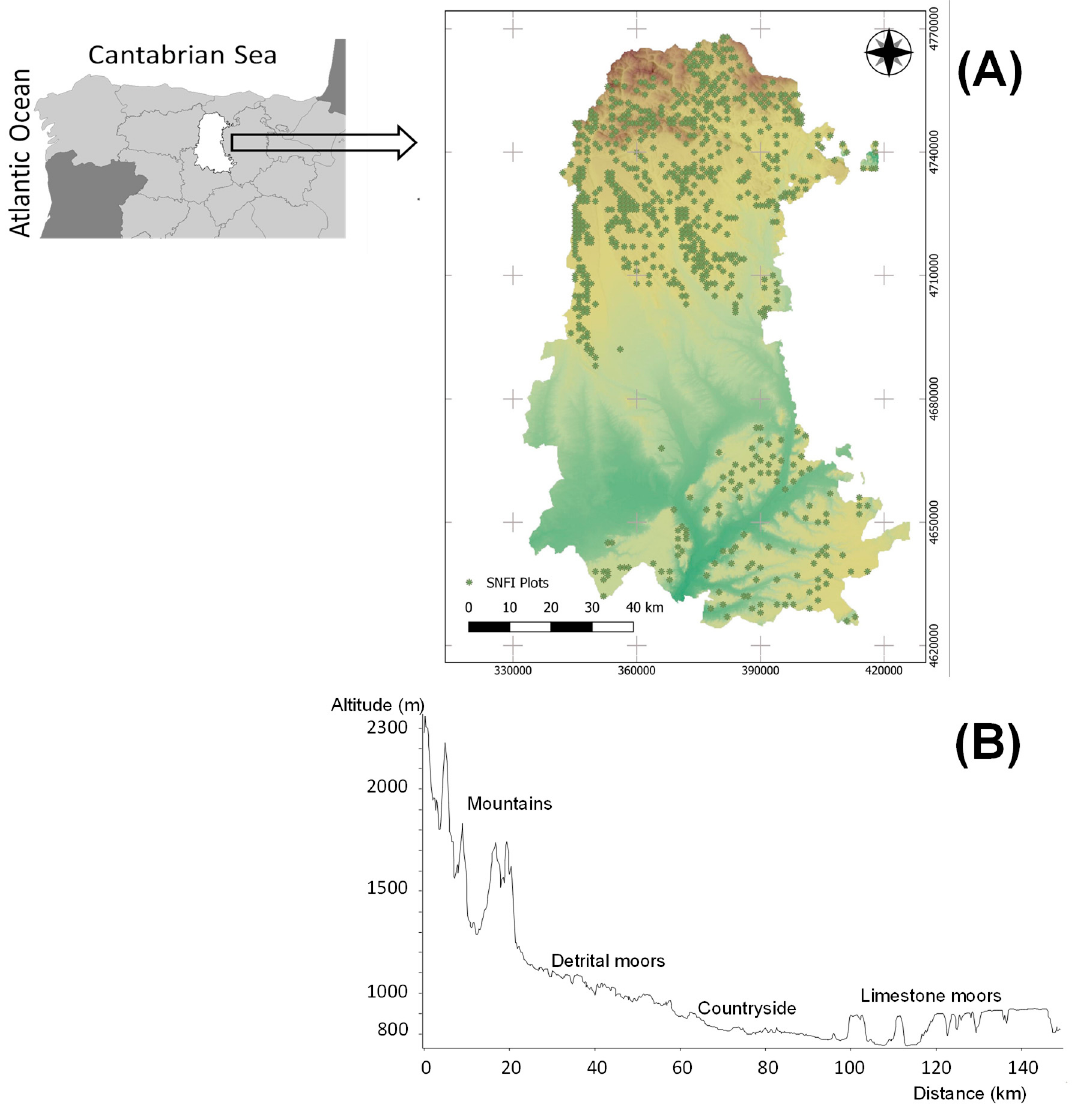
Figure 1. ( A ) Location of 772 field plots from 3SNFI considered for study in the Palencia province (Spain). Plots are represented over the Digital Elevation Model (DEM 200 m) using QGIS 3.16.6. ( B ) Topographic gradient of the Palencia province from the north (mountains) to the south (limestone moors), obtained from DEM 25 m. Both DEM from MDT2000 © Instituto Geográfico Nacional de España).